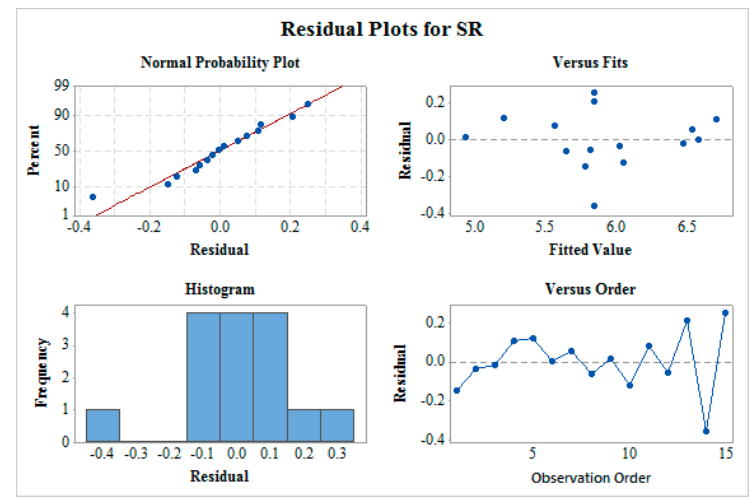
Figure 4. Residual plot for surface roughness (SR).